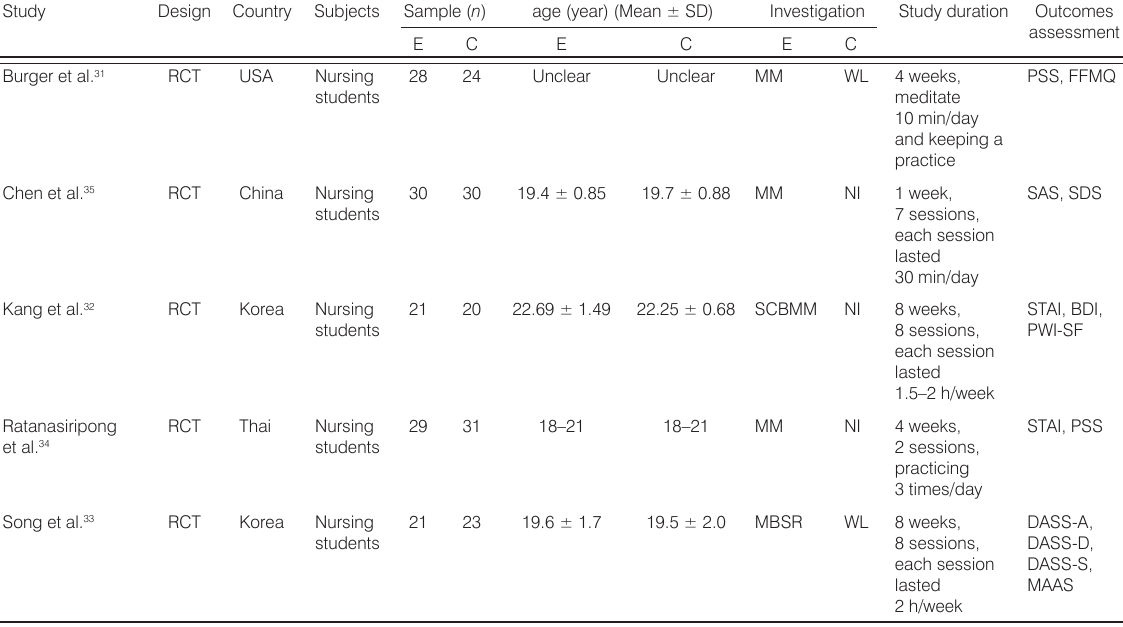
Table 1. Main characteristics of included